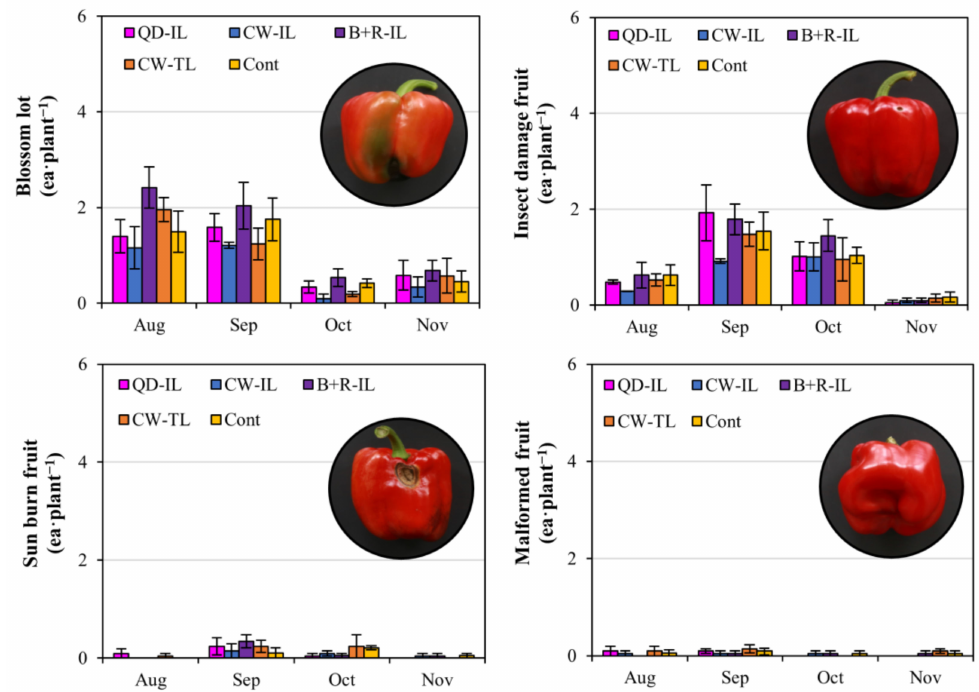
Figure 4. Each type of non-marketable fruit generated during the supplemental lighting period and degree of occurrence. Supplemental lighting treatments: QD-IL, QD inter-lighting; CW-IL, cool-white inter-lighting; B+R-IL, blue + red inter-lighting; CW-TL, cool-white top-lighting; Cont, without supplemental lighting. Vertical bars indicate ± SEM (n = 3). These results were not statistically significant due to the large standard error between each